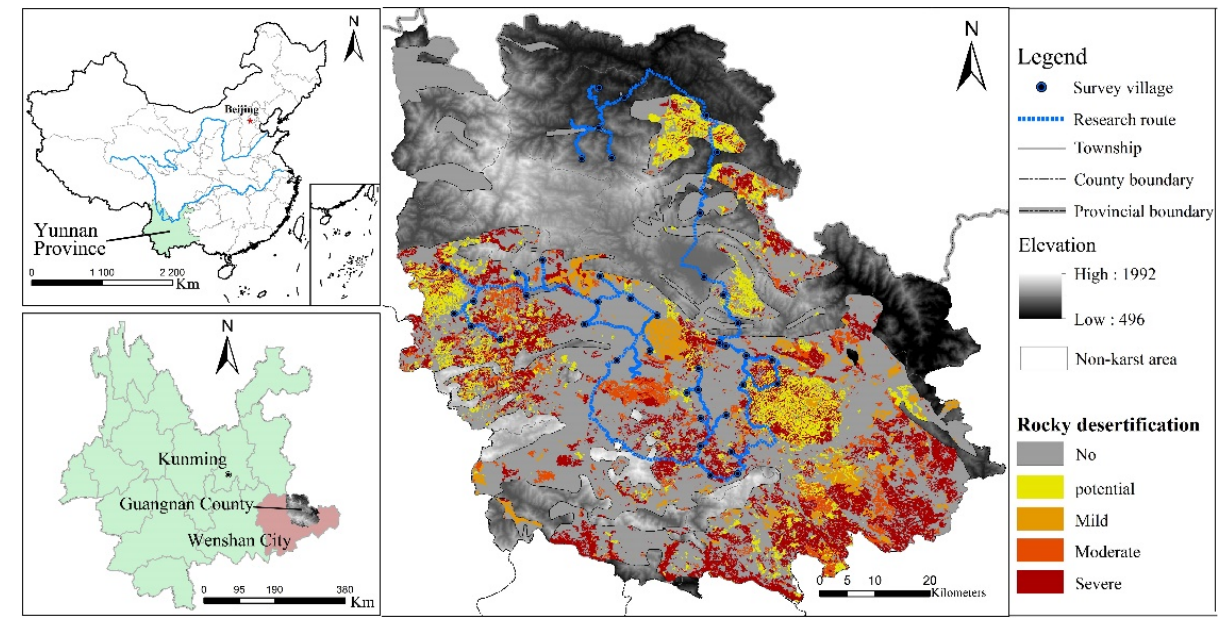
Figure 2. Location of the study area.